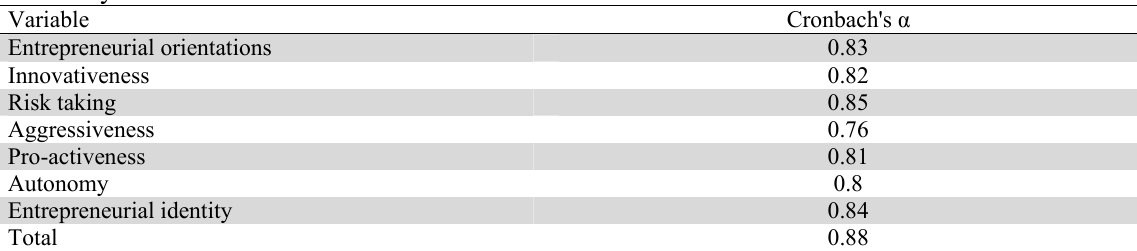
Reliability test